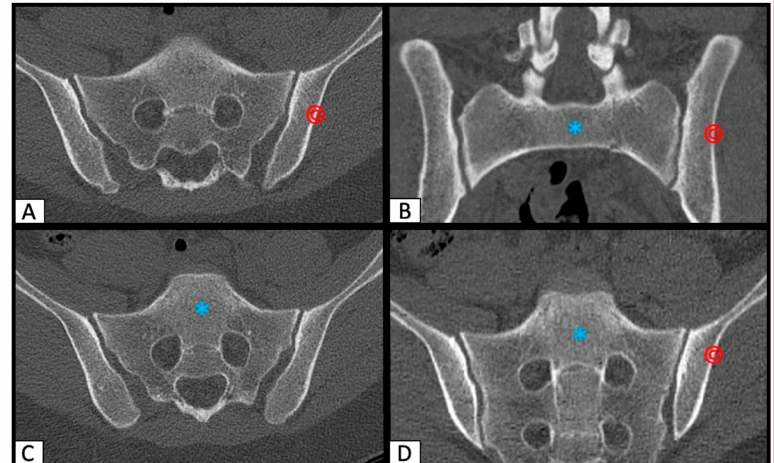
Figure 1. Determination of the perfect safe osseous corridor on axial ( A ), ( C ) as well as inlet ( B ) and outlet ( D ) orientated CT (computed tomography) scan slices. ( A ) shows the entrypoint (red circle), ( C ) the endpoint (blue asterix) for the SI (sacro-iliacal) screw in the axial view. ( B ) shows the planned position for the SI screw in inlet-, ( D ) in outlet orientated